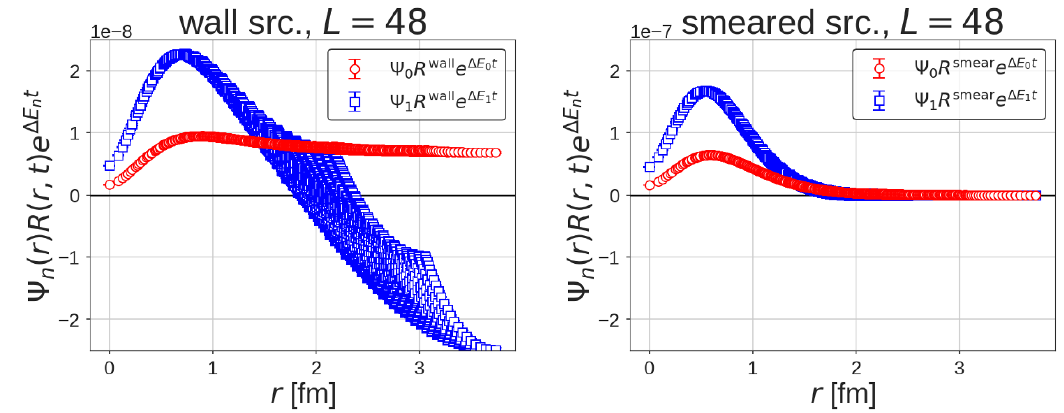
Figure 8 . The overlap between the R -correlator and the eigenfunction, (cid:9) y function of r at t=a = 13 on L = 48 for the ground state ( n = 0, red circles) and the (cid:12)rst excited state ( n = 1, blue squares) in the case of the wall source (left) and the smeared source (right).